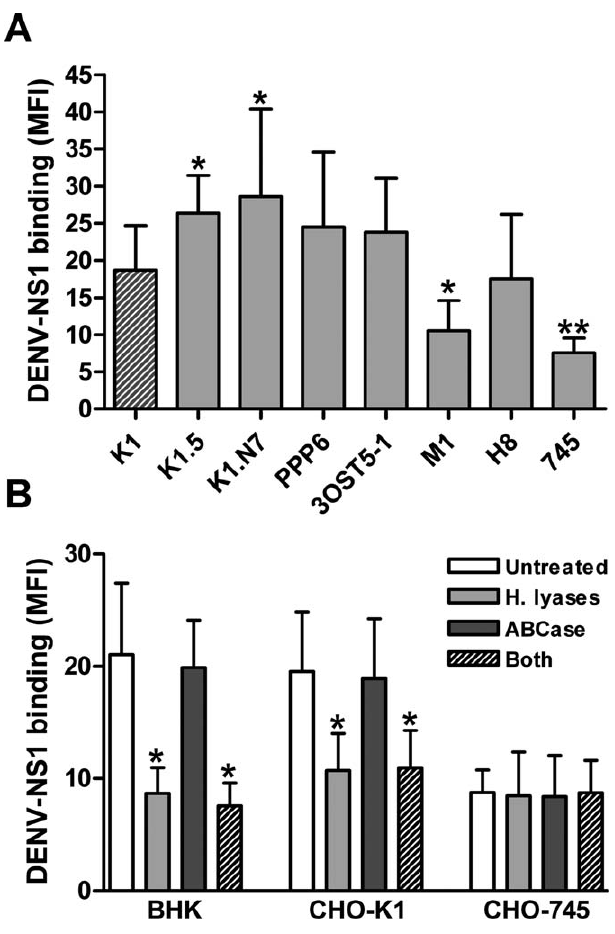
Figure 3. Binding of DENV NS1 to Cell Surface Is GAG-Dependent (A) DENV NS1 binding to wild type (K1) and seven mutant CHO cell lines that overexpress (K1.5, K1.N7, PPP6, and 3OST5–1) or are defective (M1, H8, and 745) for specific enzymes in GAG synthesis. Binding and staining were performed at 4 8 C and analyzed by flow cytometry. Data are expressed as the specific MFI of staining after subtraction of background antibody binding in the absence of NS1. The error bars indicate